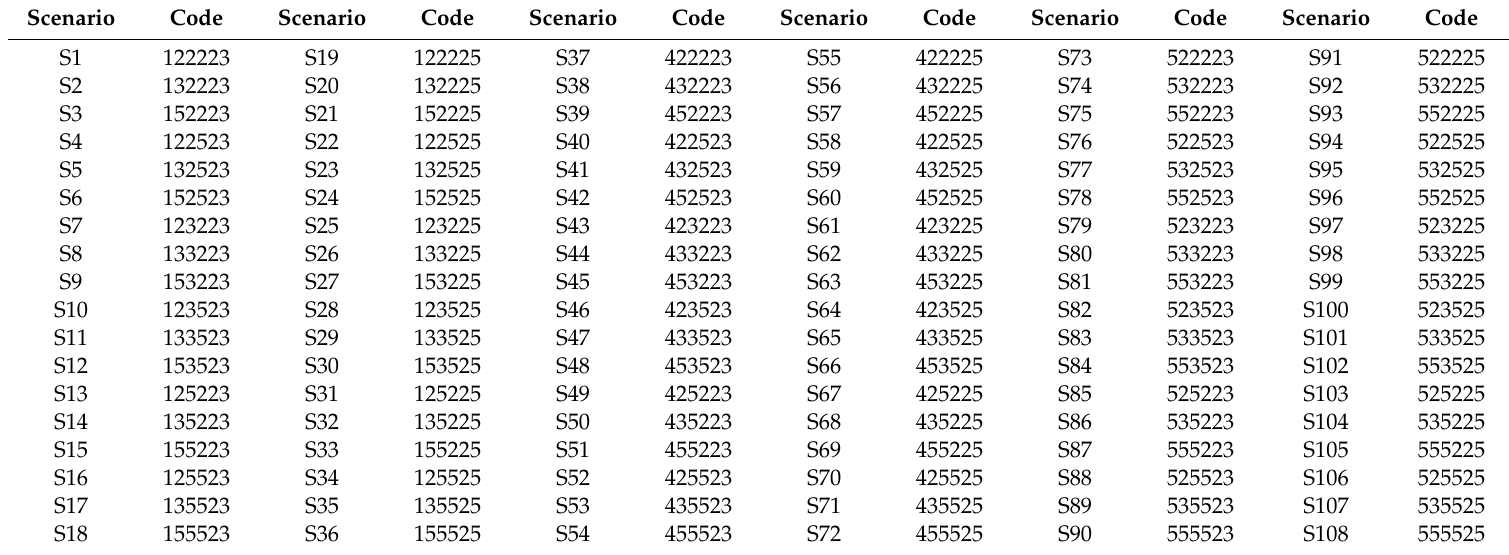
Table 5. Generated scenarios and their